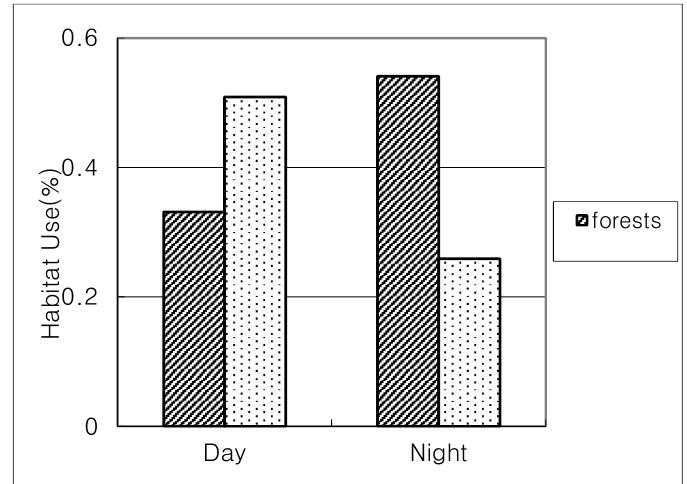
Figure 1. Habitat use pattern of red-crowned crane during daytime (06:00–18:00) and nighttime